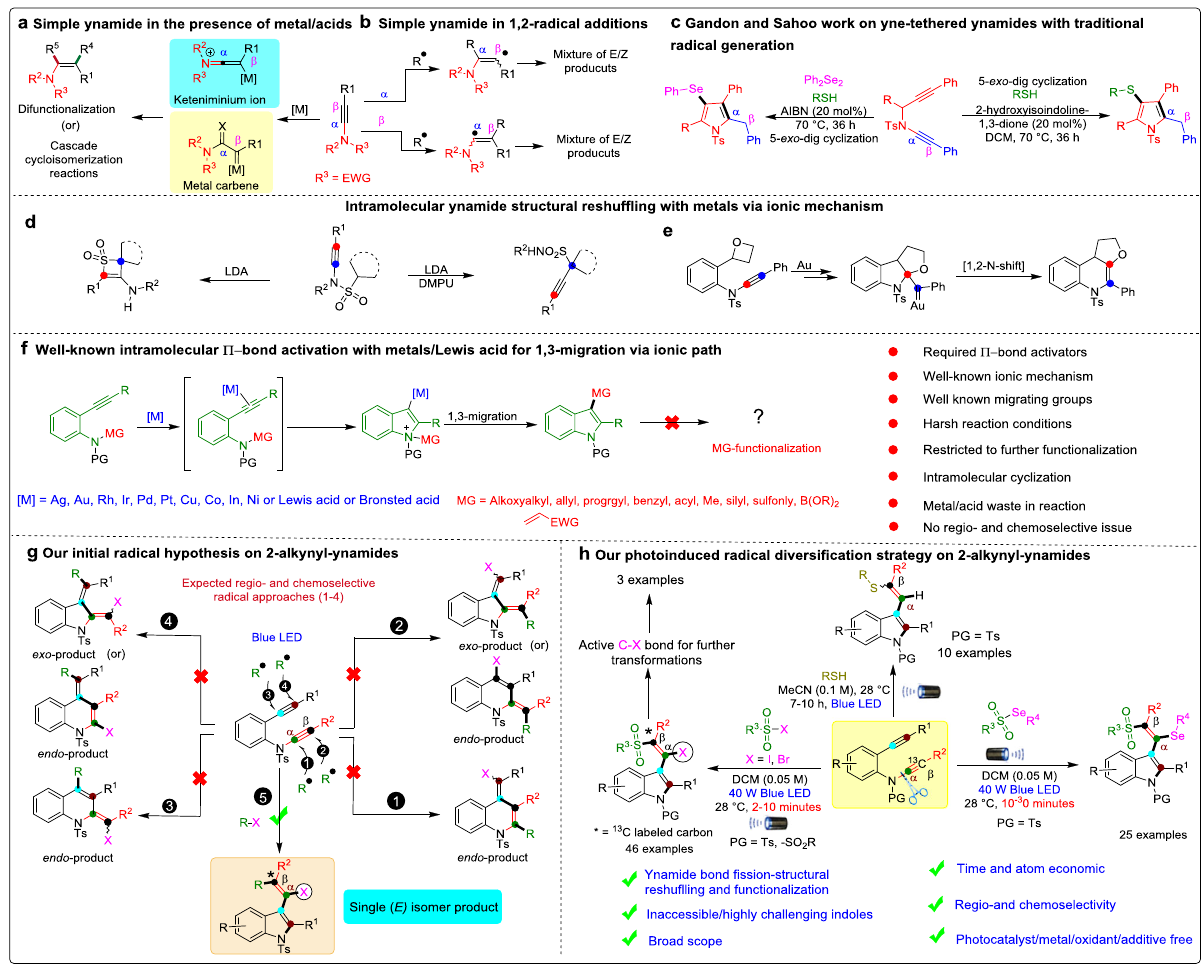
Fig. 1 Previous literature and background for reaction development. a Simple ynamide in a metal/Lewis acid. b Regioselective radical addition on α , β - carbons. c Radical chalcogen-triggered cascade reactions on yne-tethered ynamides. d Intramolecular ynamide structural reshuf fl ing with lithium diisopropylamine (LDA) via an ionic pathway. e Intramolecular ynamide structural reshuf fl ing with gold-catalyst. f Well-known ionic pi-bond activator with a metal/Lewis acid in a skeletal rearrangement of o ‐ alkynylanilines. g Our initial hypothesis and the observed ynamide bond fi ssion, structural reshuf fl ing and functionalization processes on 2-alkynyl-ynamides. h Photoinduced radical diversi fi cation strategy for inaccessible/challenging highly substituted